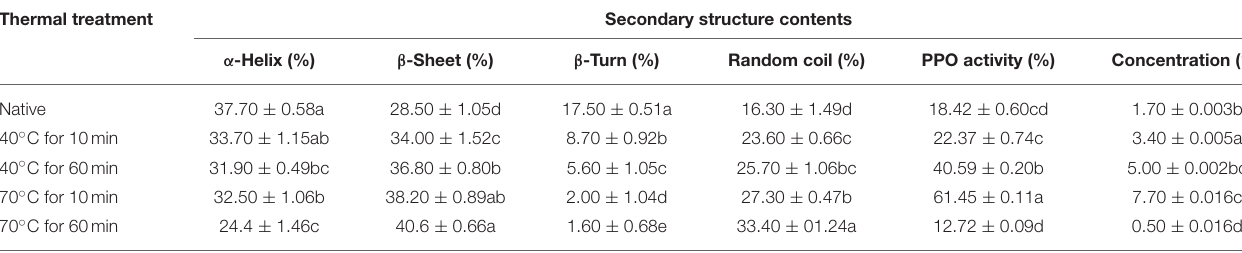
TABLE 1 | Secondary structure contents of native and thermally treated PPO. Thermal